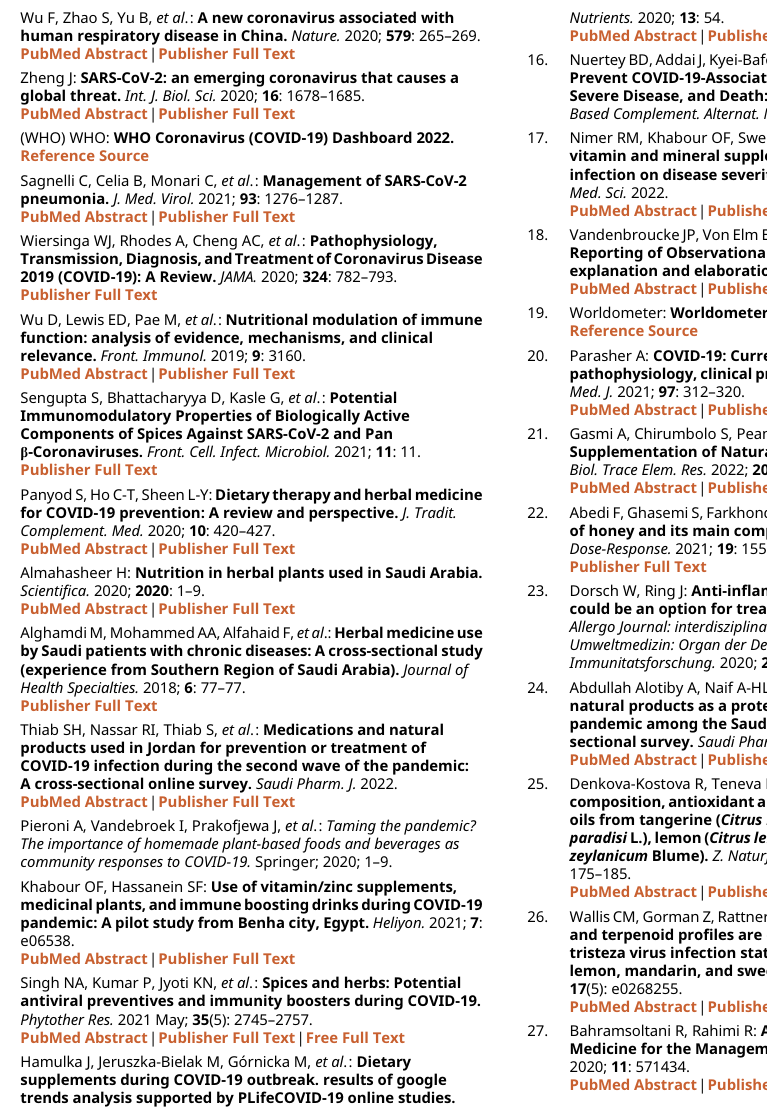
Figshare: Natural Products Raw Data. https://doi.org/10.6084/m9.figshare.19758820. 67